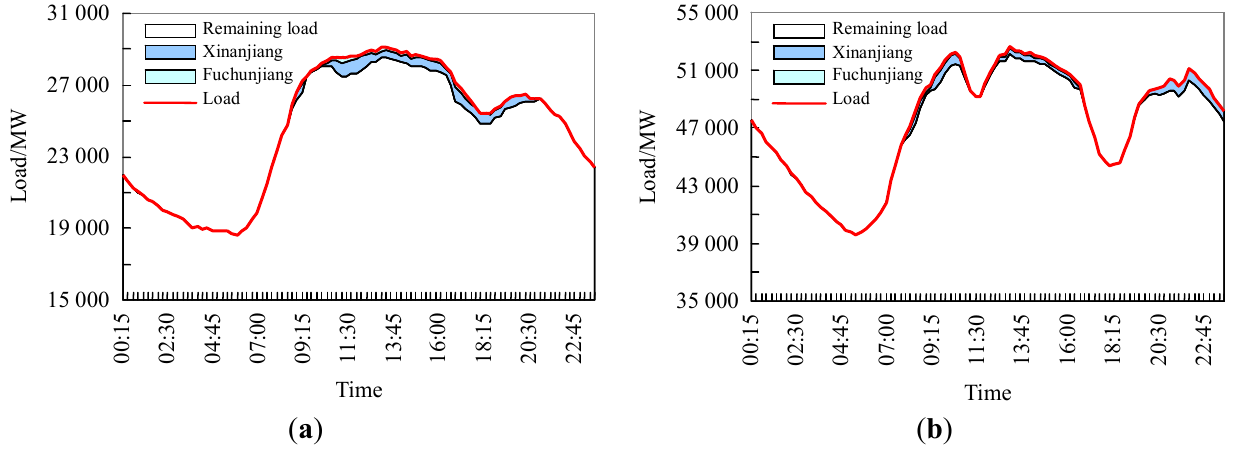
Figure 6. Load balance profiles in Scheme 1: ( a ) Shanghai Power Grid (SHPG); and ( b ) Zhejiang Power Grid (ZJPG).